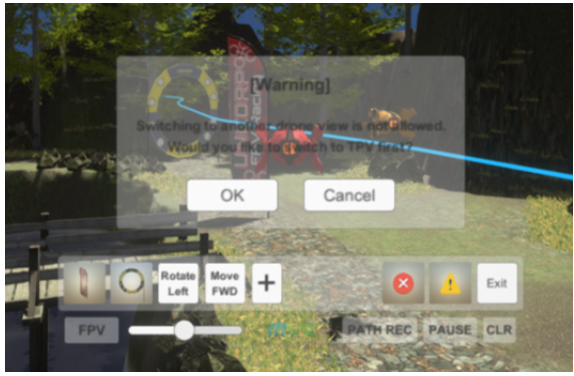
Figure 12. Modal window.